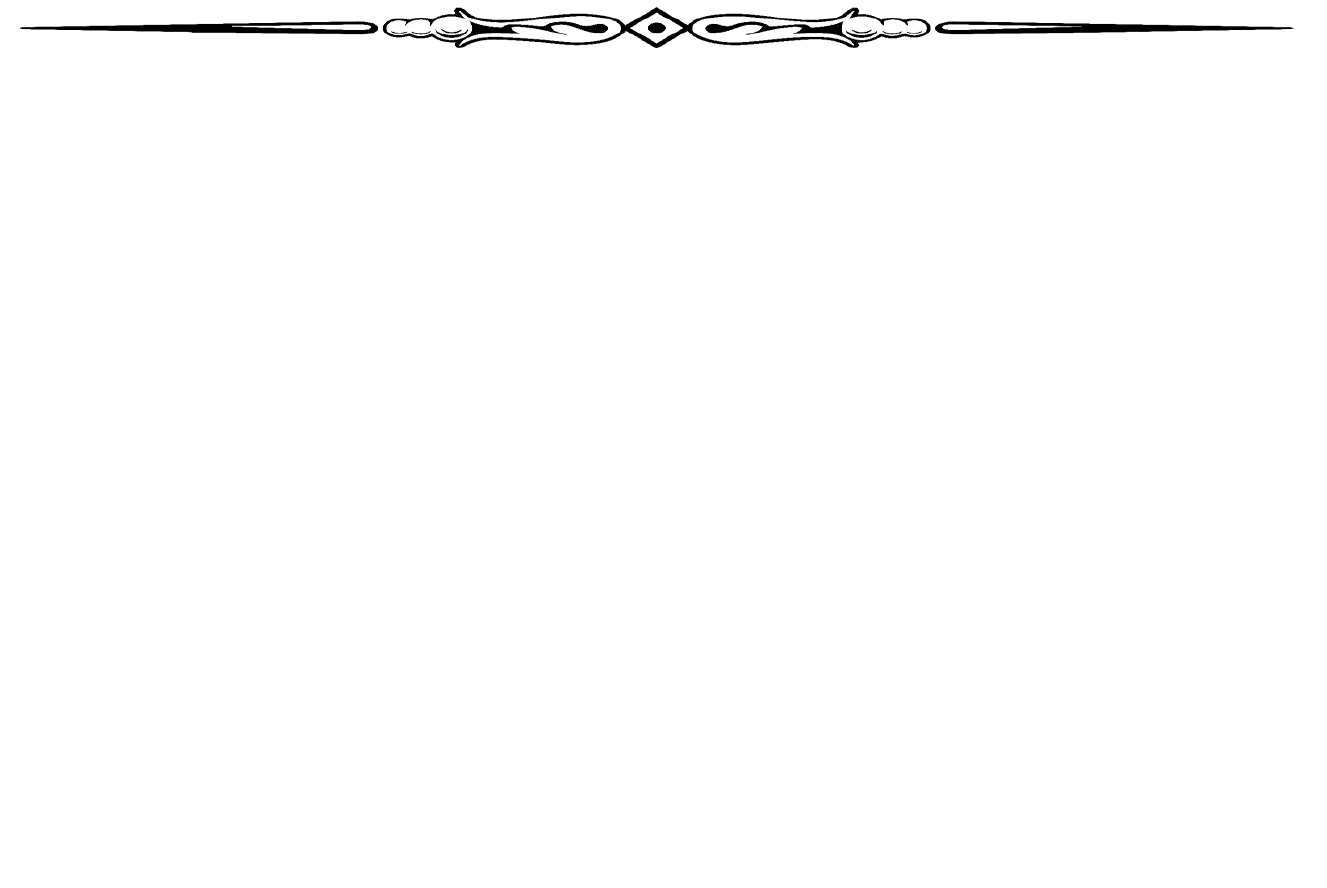
Figure 4: Exposure of dosimeter samples at 300 Gy